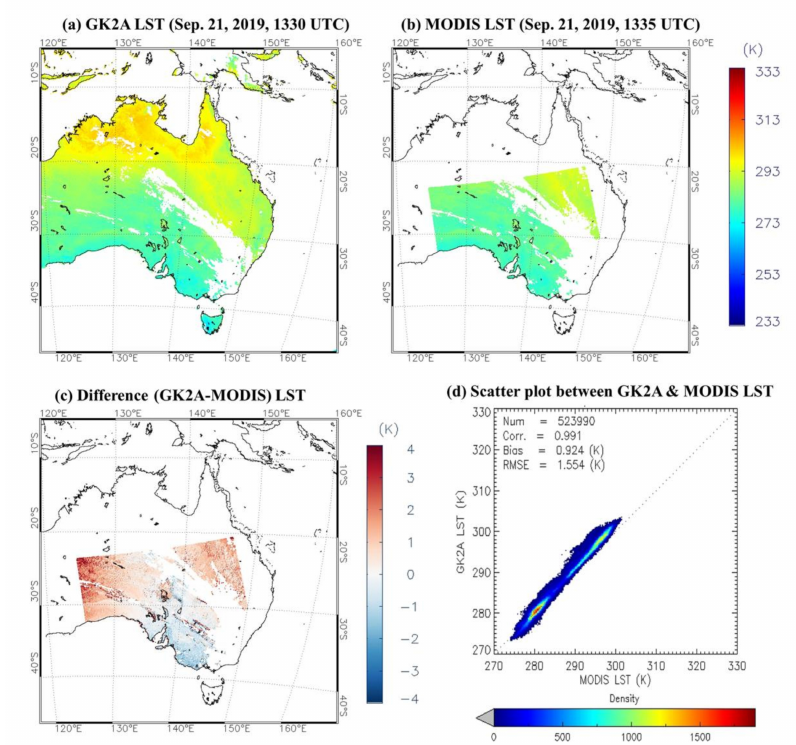
Figure 9. Spatial distribution of ( a ) GK2A LST, ( b ) MODIS (MOD11_L2) LST, ( c ) di ff erences between GK2A and MODIS LSTs, and ( d ) scatter plot between GK2A and MODIS (MOD11_L2) LSTs for 21 September 2019, 1330 and 1335 UTC (gray dotted line in ( d ) represents the 1:1 line).